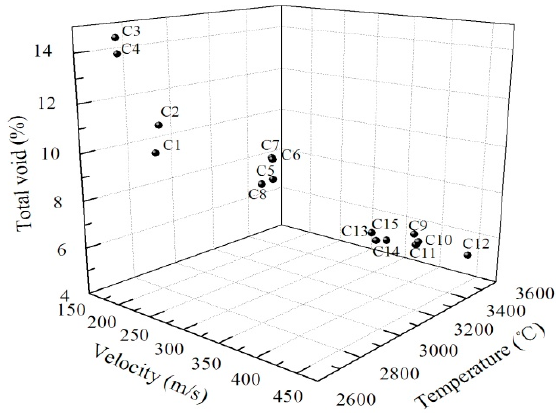
Figure 2. The relationship between the temperature and velocity of flying particles and the total voids of the coatings.